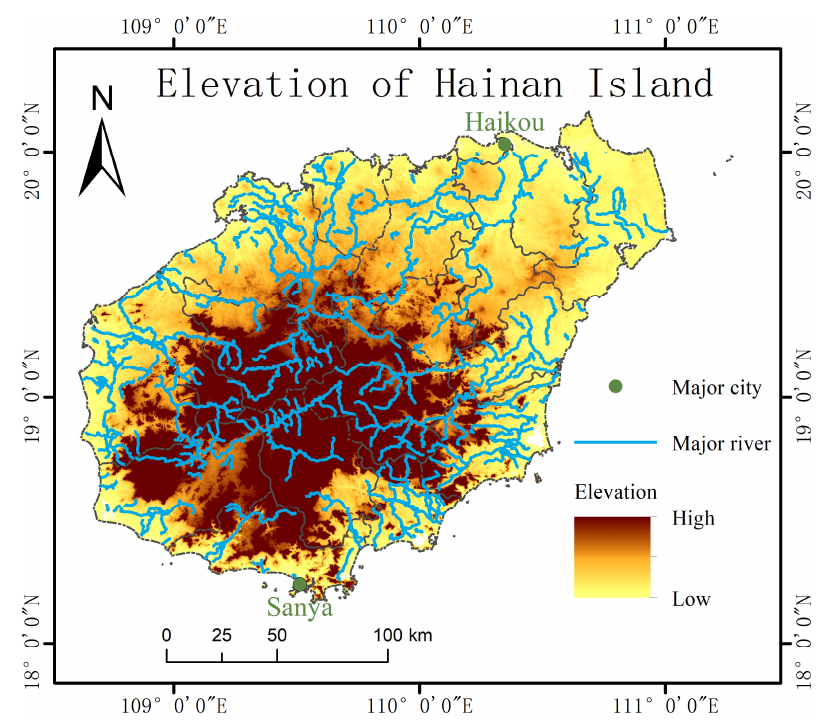
Figure 1. Elevation of Hainan Island, including the major rivers and two major cities used in this study.